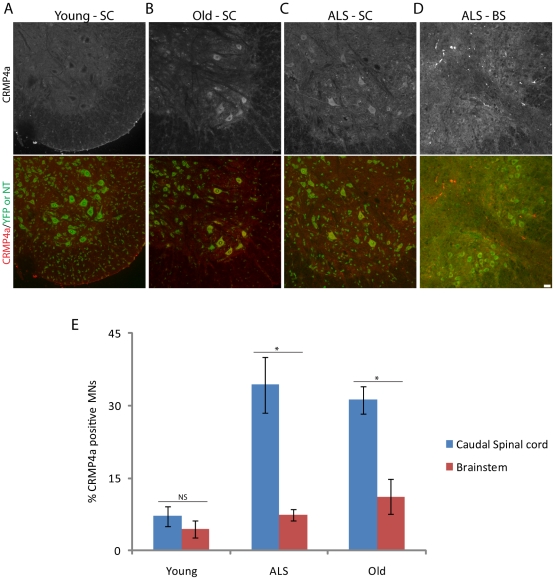
Regulation of CRMP4a in aging and ALS.A–D) CRMP4a immunoreactivity of motor neurons in caudal spinal cord (SC) from young adult wild type (A), old wild-type (B) and symptomatic SOD-G93A (C) mice and brainstem (BS) of a symptomatic SOD-G93A mouse (D). Somata are labeled with Neurotrace (A, B, D) or YFP (C). E) Percent of motor neurons immunoreactive for CRMP4a in spinal cord and brainstem of young adult, old, and symptomatic SOD-G93A mice. Each bar represents mean ± SEM. *p<0.015 by t-test. Scale bar = 20 µm.